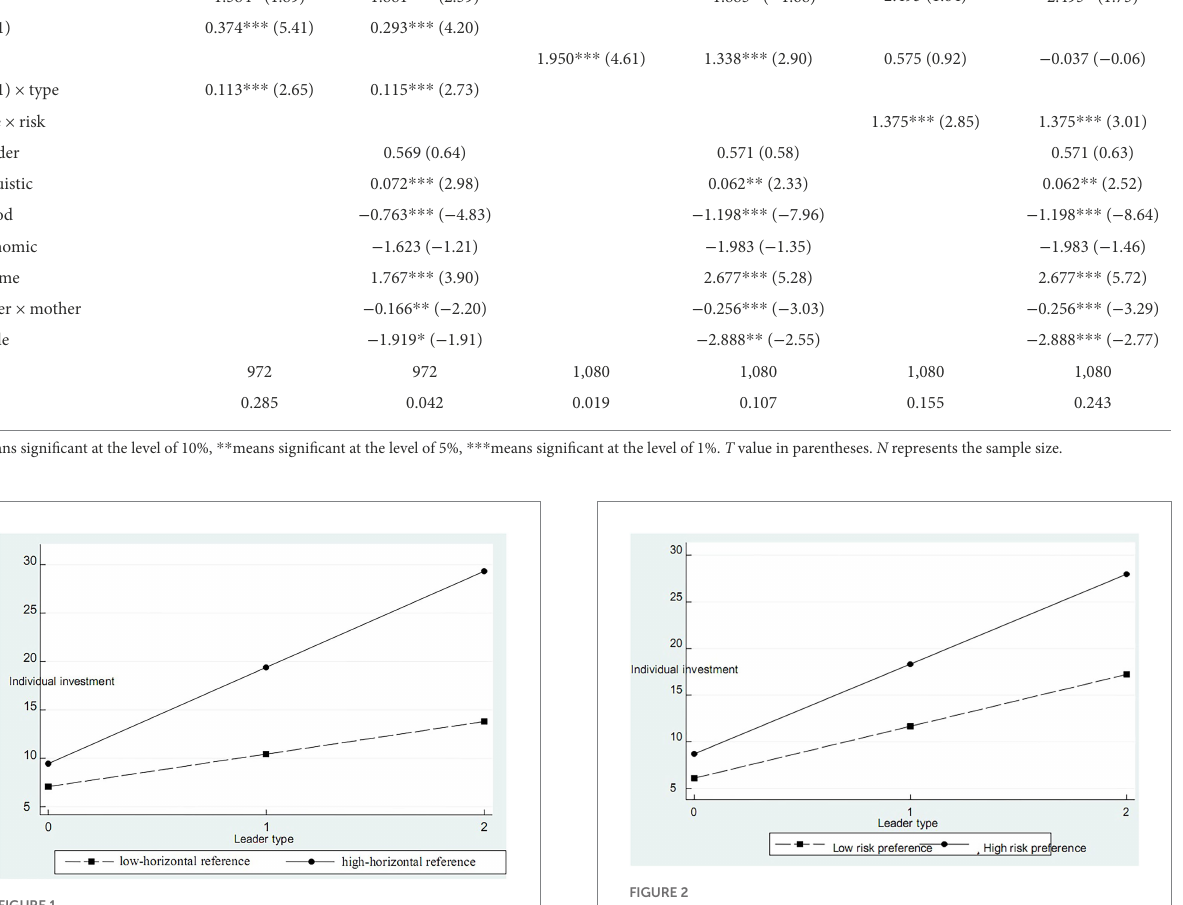
FIGURE 1 Moderator effect of horizontal reference point.